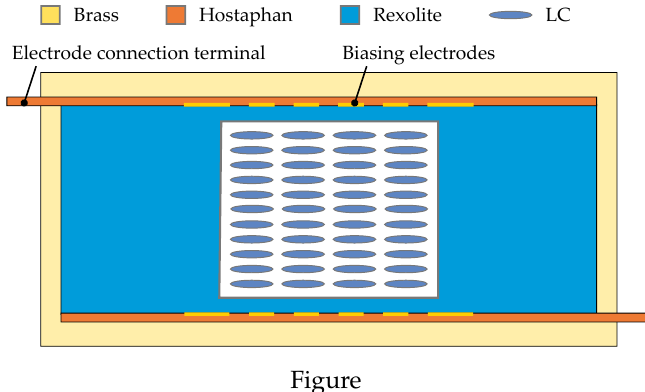
Figure 13. Schematic cross section of the metallic rectangular waveguide LC phase shifter with partial LC filling.